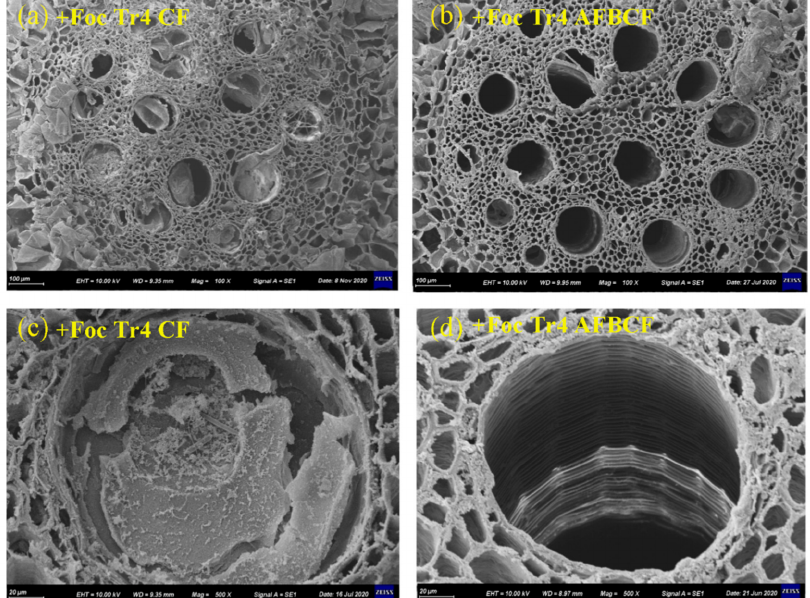
Figure 9. SEM images of banana root vessels in +Tr4 CF and +Tr4 AFBCF treatment. ( a ) Most of the vessels for +Tr4 CF treatment of roots were blocked by tylosis; ( b ) The vessels of +Tr4 AFBCF root were hardly found to be blocked by tylosis; ( c ) +Tr4 CF vessels were blocked by tyloses; ( d ) +Tr4 AFBCF vessels were unobstructed. CF stands for conventional fertilizer. AFBCF stands for alkaline fertilizer and biocontrol